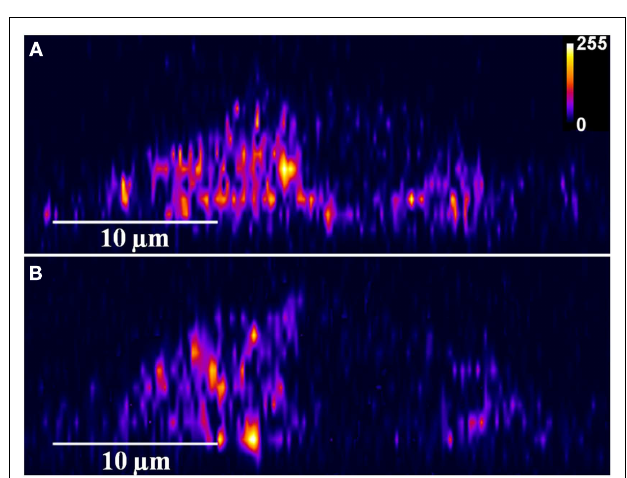
FIGUREA1 | Depolarization induces serotonin exocytosis. X - Z slices of three photon serotonin images of a single cell (of cultured serotonergic neurons) (A) before and (B) 20min after depolarization (Intensities are false color coded).